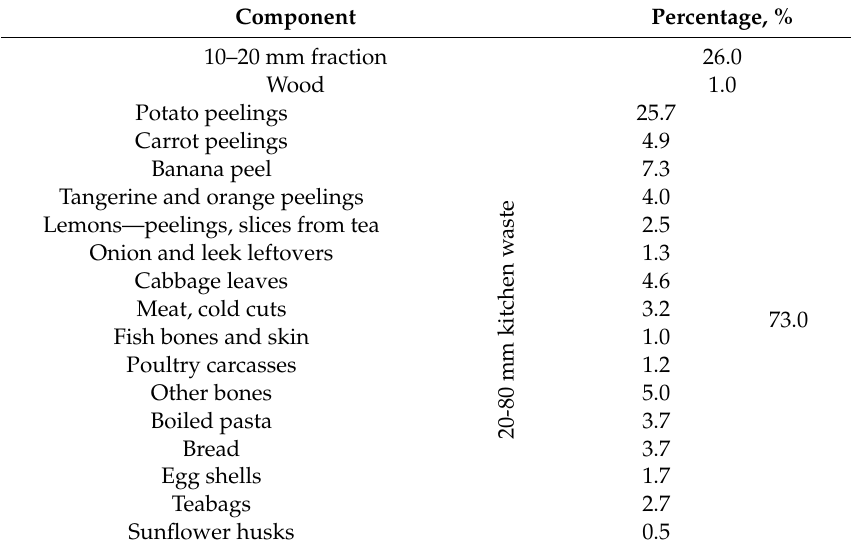
Table 1. Morphological composition of bio-waste used in the research; average values.